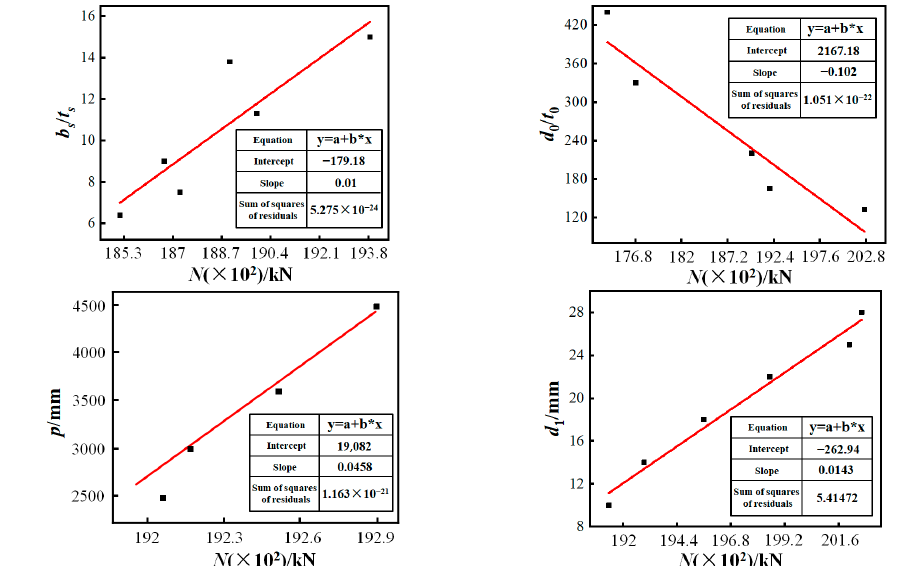
Figure 26. Regression analysis: key influencing factors.